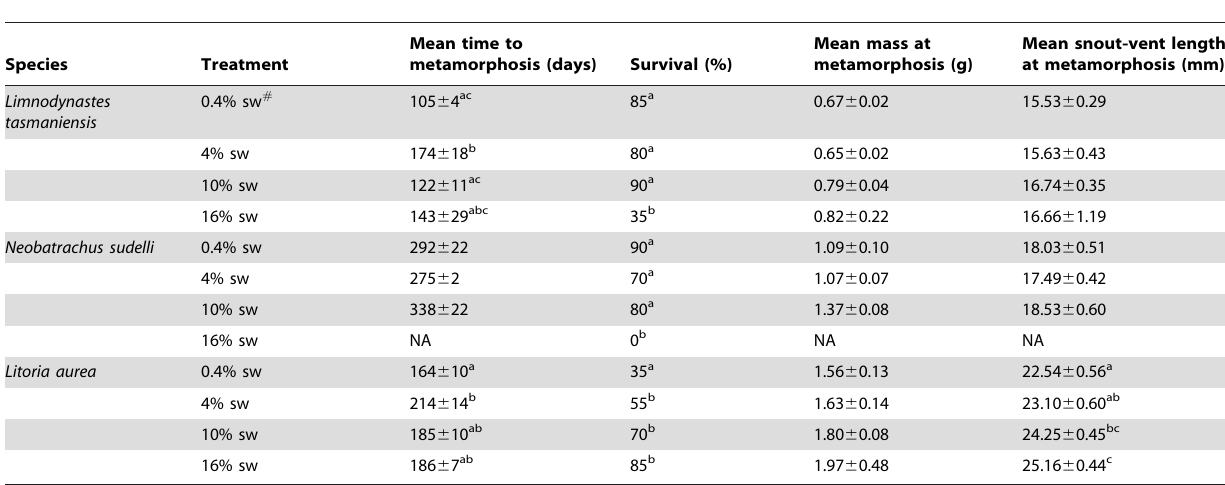
Table 1. Mean time to metamorphosis, mean mass at metamorphosis, mean snout-vent length at metamorphosis and percentage survival of metamorphs under varying salinity treatments (mean 6 s.e.), n =20 for all groups unless otherwise indicated.